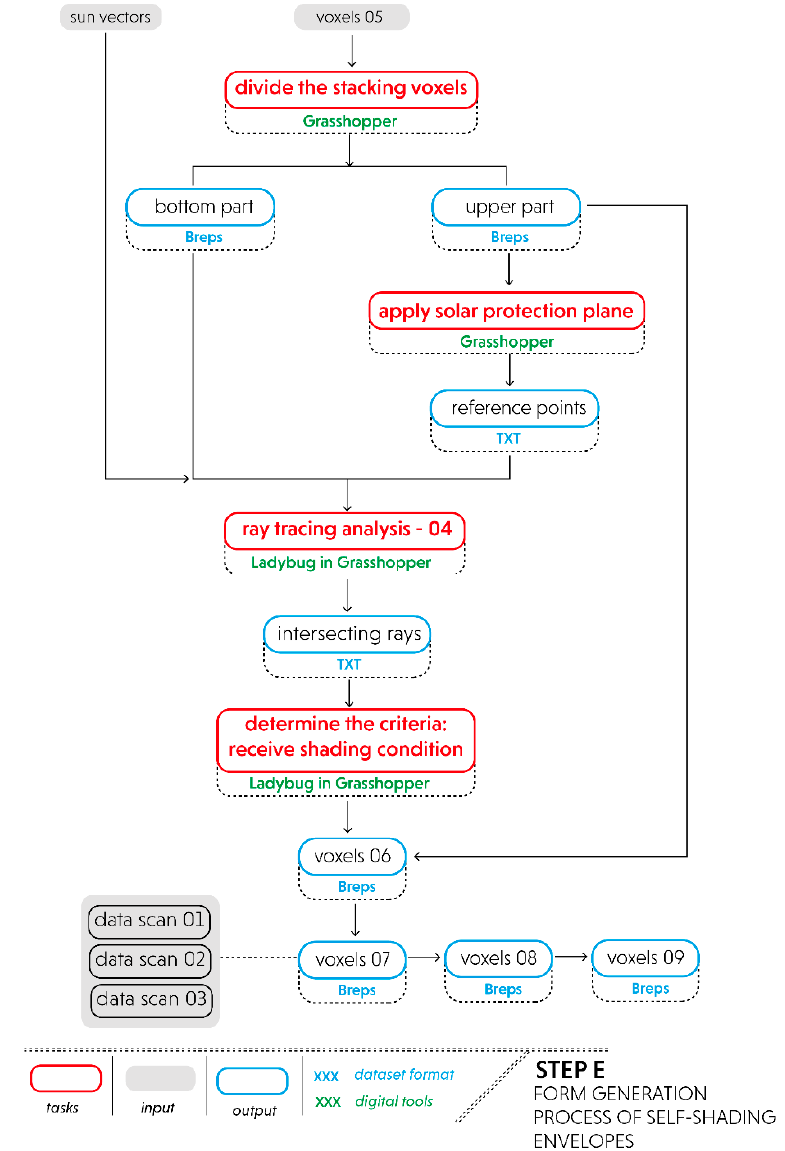
Figure 6. Detailed procedures for generating the final output of self-shading envelopes.